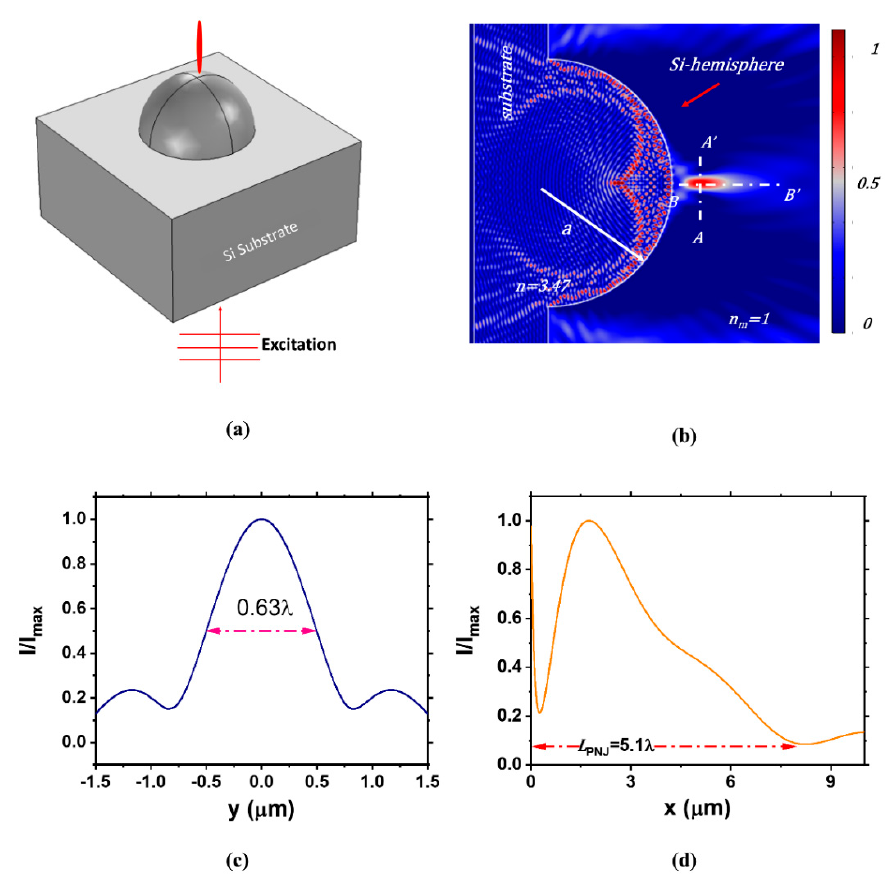
Figure 2. The geometry of the proposed structure ( a ). Electric field intensity patterns of PNJ formed in a photonic chip with Si − hemisphere ( b ). A prominent PNJ can be seen at the exterior of hemisphere. Transverse intensity profile is shown in ( c ) and the length in ( d ).